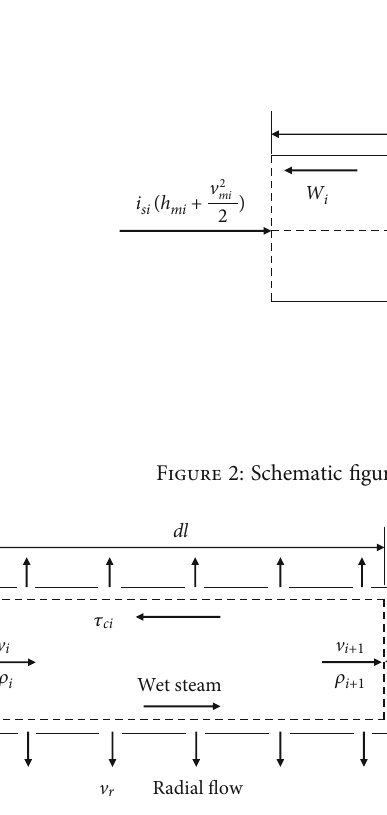
Figure 3: Schematic fi gure of momentum conservation in an in fi nitesimal